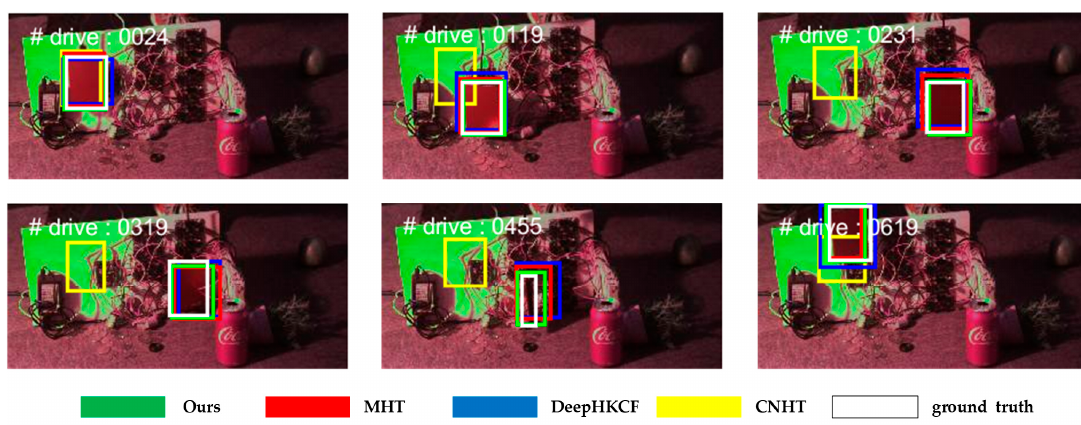
Figure 12. Tracking result of the drive sequence.